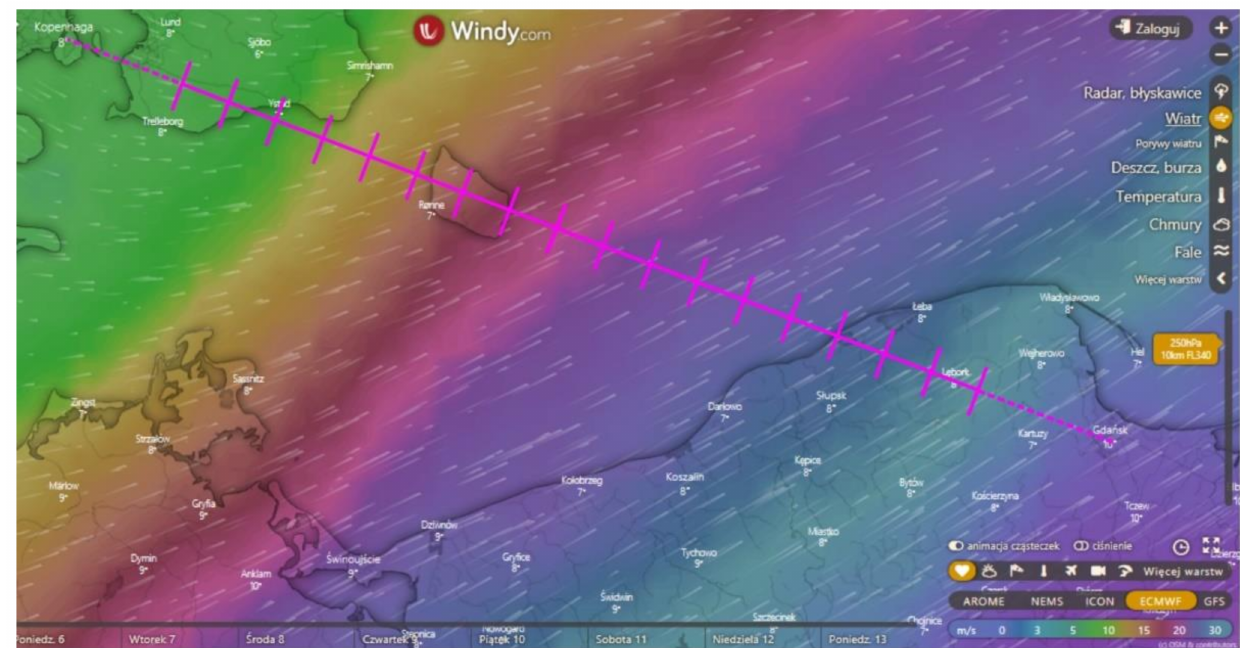
Figure 4. Visualization of wind directions and speeds at 10 km in the research airspace on 6 April 2020 [30], with the trajectory in the cruise phase indicated as a purple solid line.